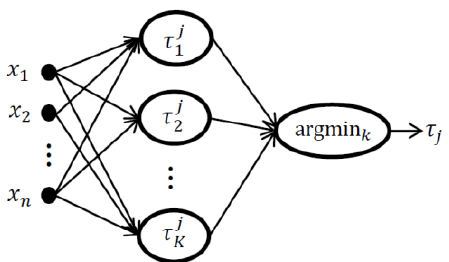
Figure 1. Architecture of an ellipsoidal neuron with dendritic processing, composed of three layers. Taken from (Arce 2017).